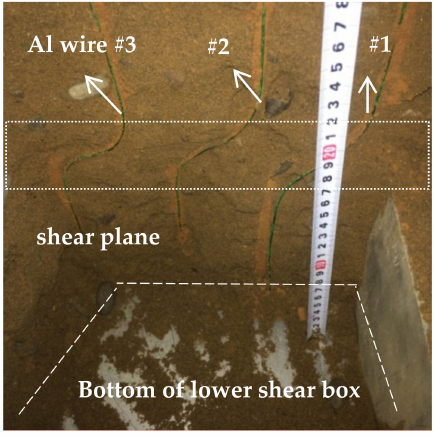
Figure 6. AA’ profile with deformation of the Al wires after